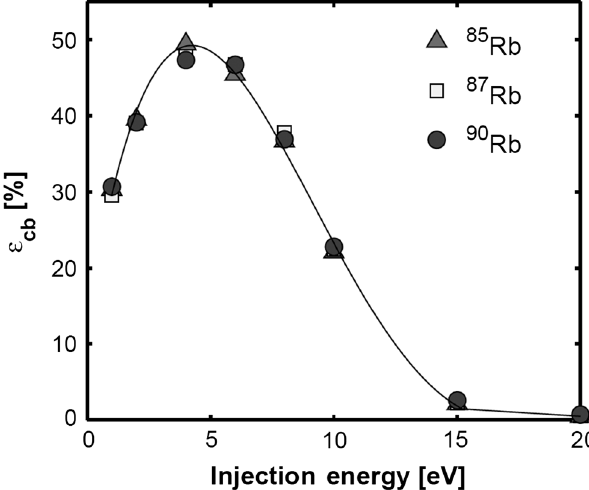
FIG. 5. Ion captured as a function of the injection energy inside the charge breeder for different Rubidium isotopes and beam injection energy. The reference curve corresponds to 85 Rb. A Gaussian fit is superimposed on each numerical curve.